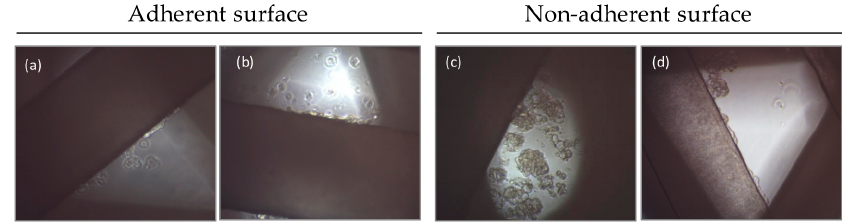
Figure 3. Inverted optical microscopy images of MCF7 cells seeded on scaffolds with adherent and non-adherent wells. ( a ) 45 ˝ and ( b ) 60 ˝ scaffolds in adherent conditions. Cells were attached both at scaffolds and at the surface; ( c ) 45 ˝ and ( d ) 60 ˝ scaffolds in non-adherent conditions. Cells were attached at the scaffolds and also formed suspension aggregates between the PCL filaments.